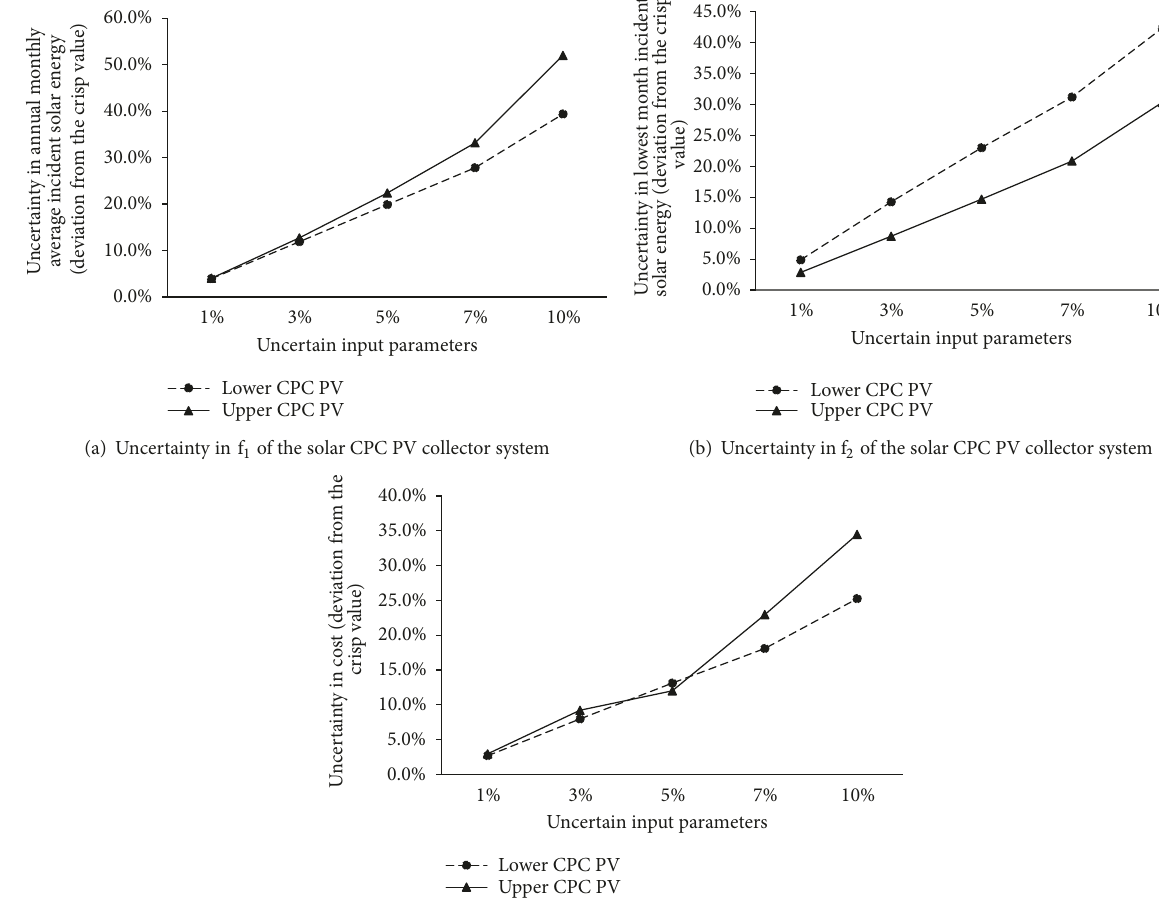
(c) Uncertainty in f 3 of the solar CPC PV collector system Figure 5: Variation of deviations of f 1 , f 2 , and f 3 from the crisp value with respect to a fuzzy confidence interval.